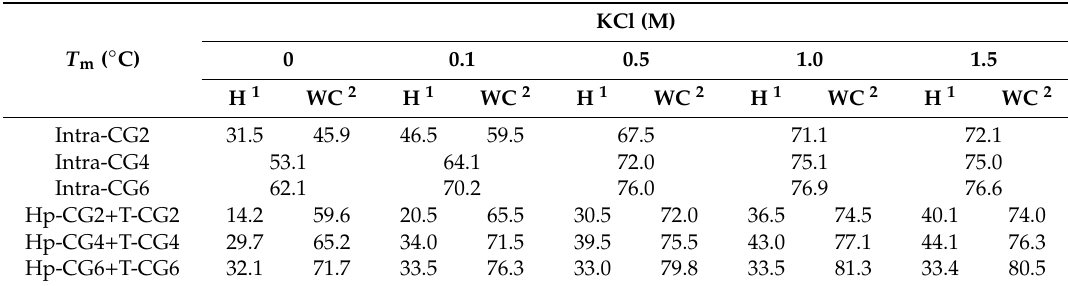
Table 2. The melting temperature of 20 µ M intramolecular and intermolecular triplexes in the absence of PEG 200 with 0, 0.1, 0.5, 1.0, and 1.5 M